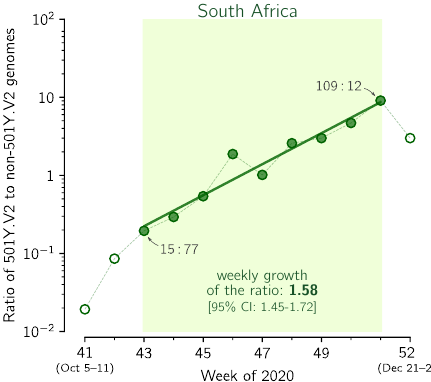
Figure 4. The replicative advantage of the 501Y.V2 strain in South Africa. Shown is the ratio of the 501Y.V2 to the non-501Y.V2 genomes collected in weeks 41–50 of 2020 in South Africa. The trend line is fitted to data points from weeks 43–50. The weekly growth rate is 1.58 [95% CI: 1.45–1.72]. Data points for selected weeks are labeled with ratios of the counts of genome sequences. The figure is based on GISAID data submitted till 12 February 2021 (provided in Supplementary Data File